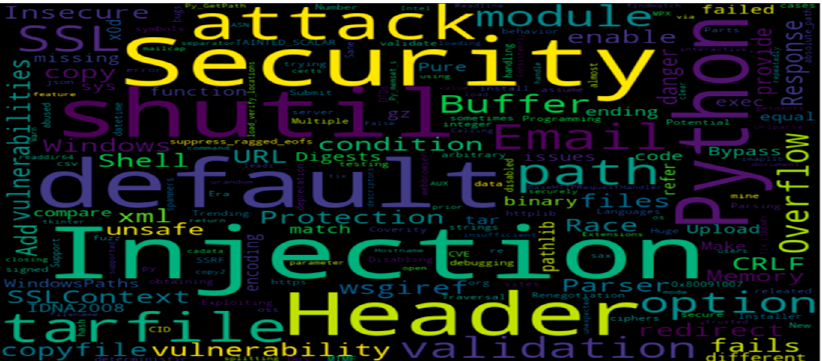
Figure 5. Word cloud of “Resource usage” error.